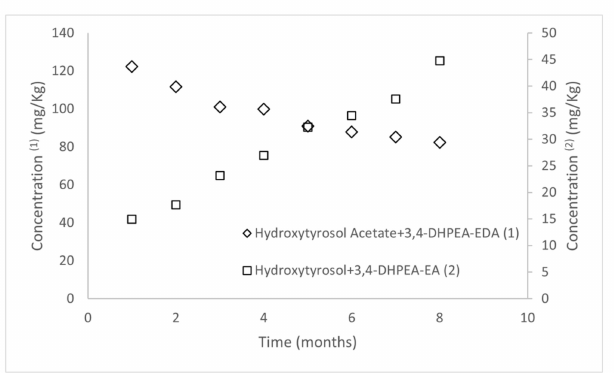
Figure 3. Evolution of the sum of oleuropein-derivate which concentrations increase (2) (3,4-DHPEA- EA and hydroxytyrosol), and the sum of oleuropein-derivate which concentrations decrease (1) (3,4-DHPEA-EDA and hydroxytyrosol acetate) throughout